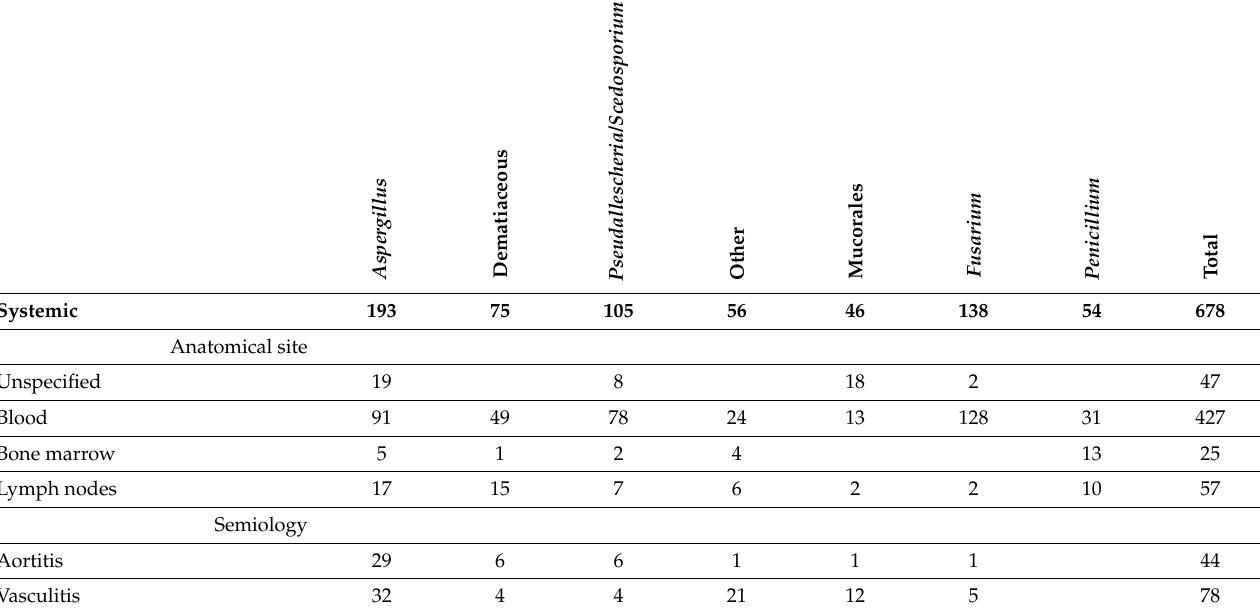
Table 2. Anatomical sites and nosological framework of the different taxa. CNS: central nervous system; and ORL: oto-rhino-laryngological. The numbers in the table correspond to